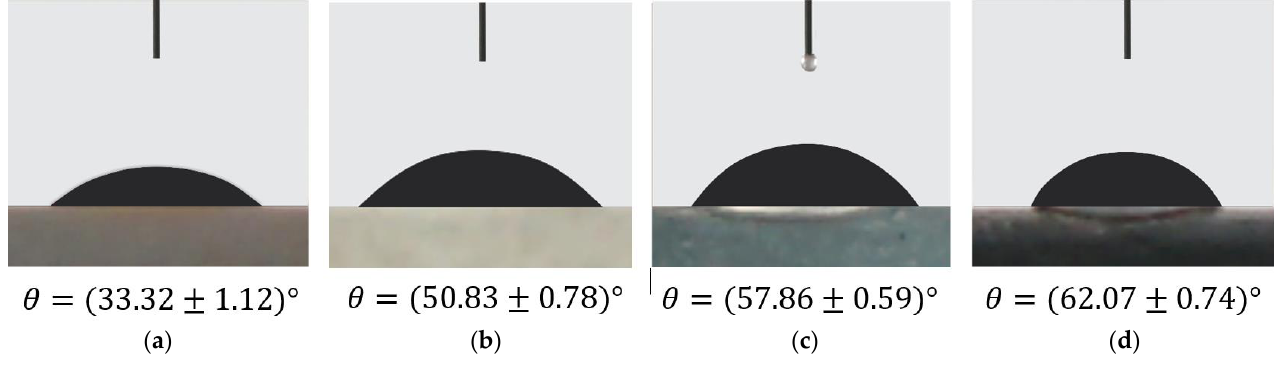
Figure 16. Water contact angle for sample: ( a ) geopolymer; ( b ) Geo–TiO 2 (3); ( c ) Geo–rGO–TiO 2 (0.5, 3), and ( d ) Geo–rGO– TiO 2 (1, 3).